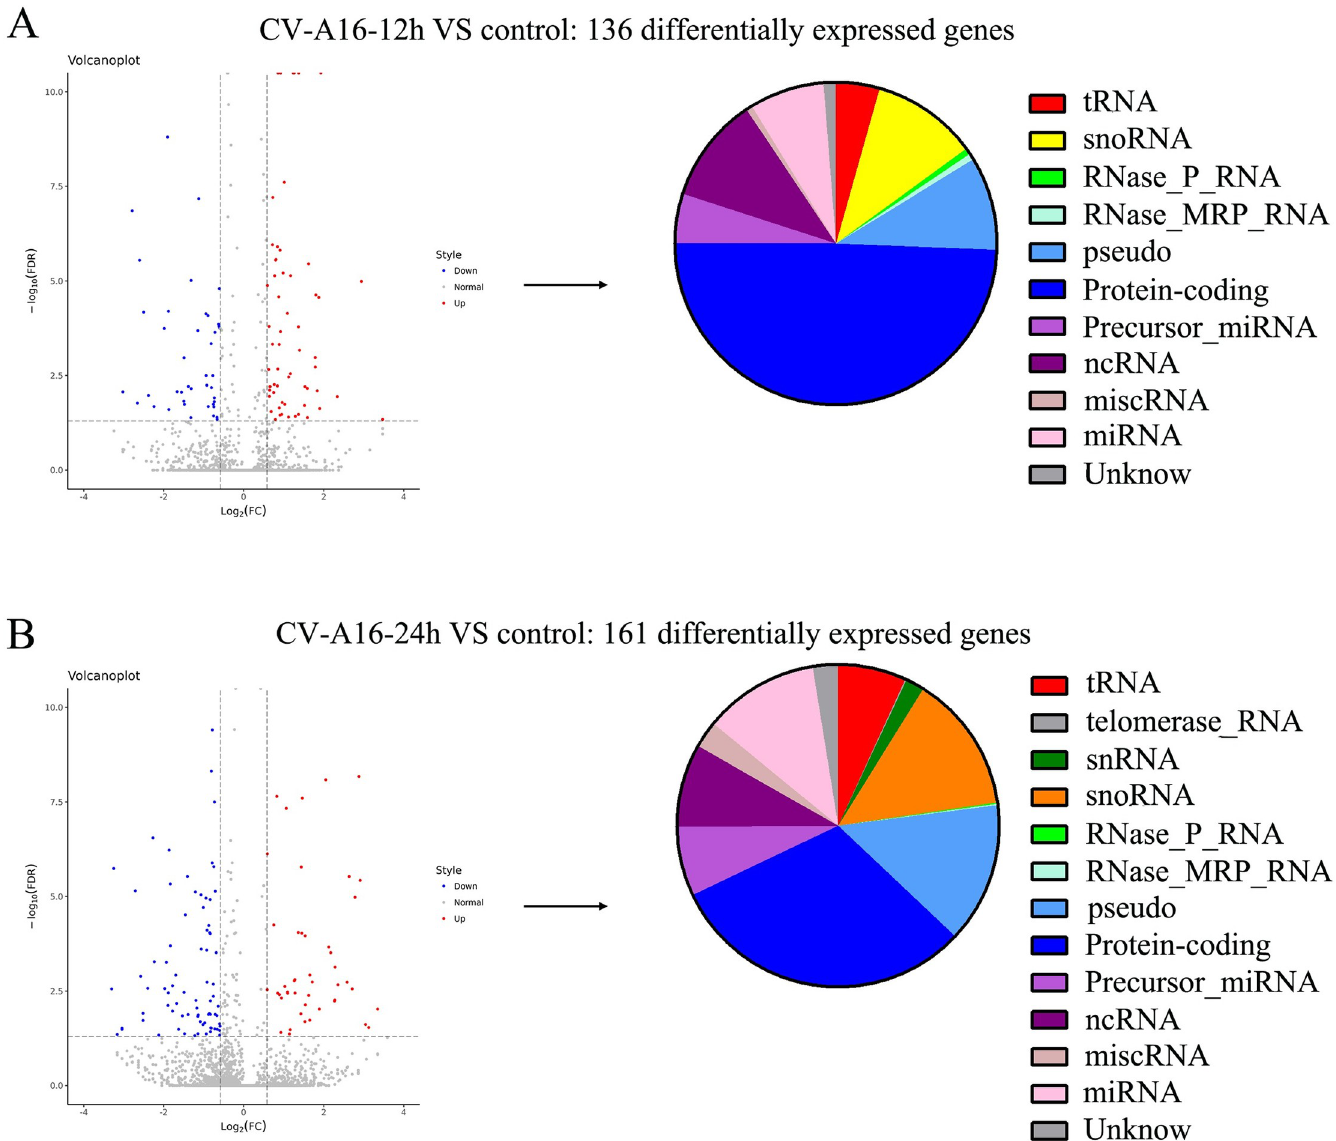
Fig 1. Differential expression of genes between the CV-A16-12 h group (A)/CV-A16-24 h group (B) and the control. Red dots represent genes that were upregulated in the CV-A16 infection groups compared to the control group, whereas blue dots represent genes that were downregulated in the CV-A16 infection groups compared to the control group. The pie chart shows the gene types of these differentially expressed genes during CV-A16 infection at different time points.